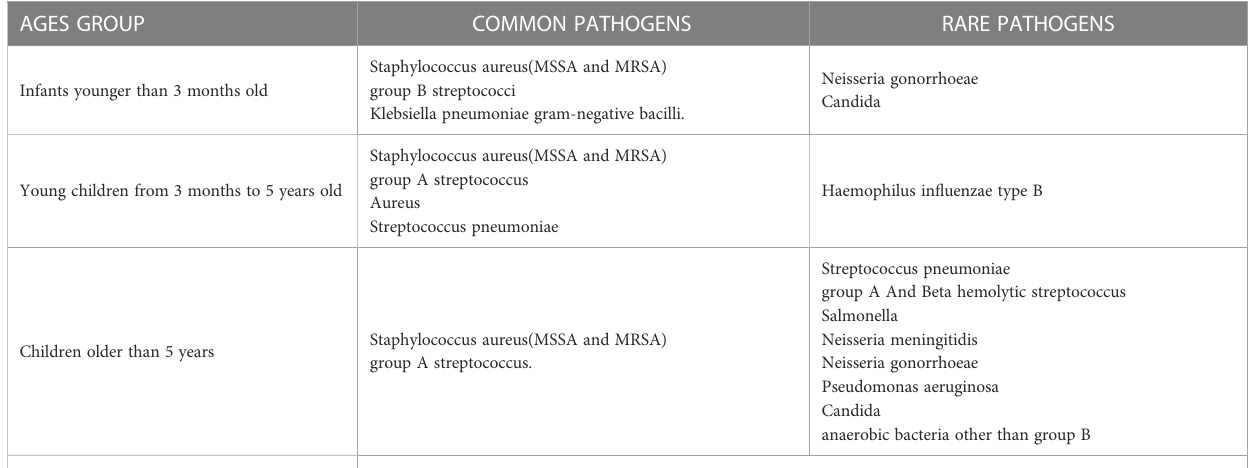
TABLE 1 Pathogenic microorganisms for septic arthritis in all age